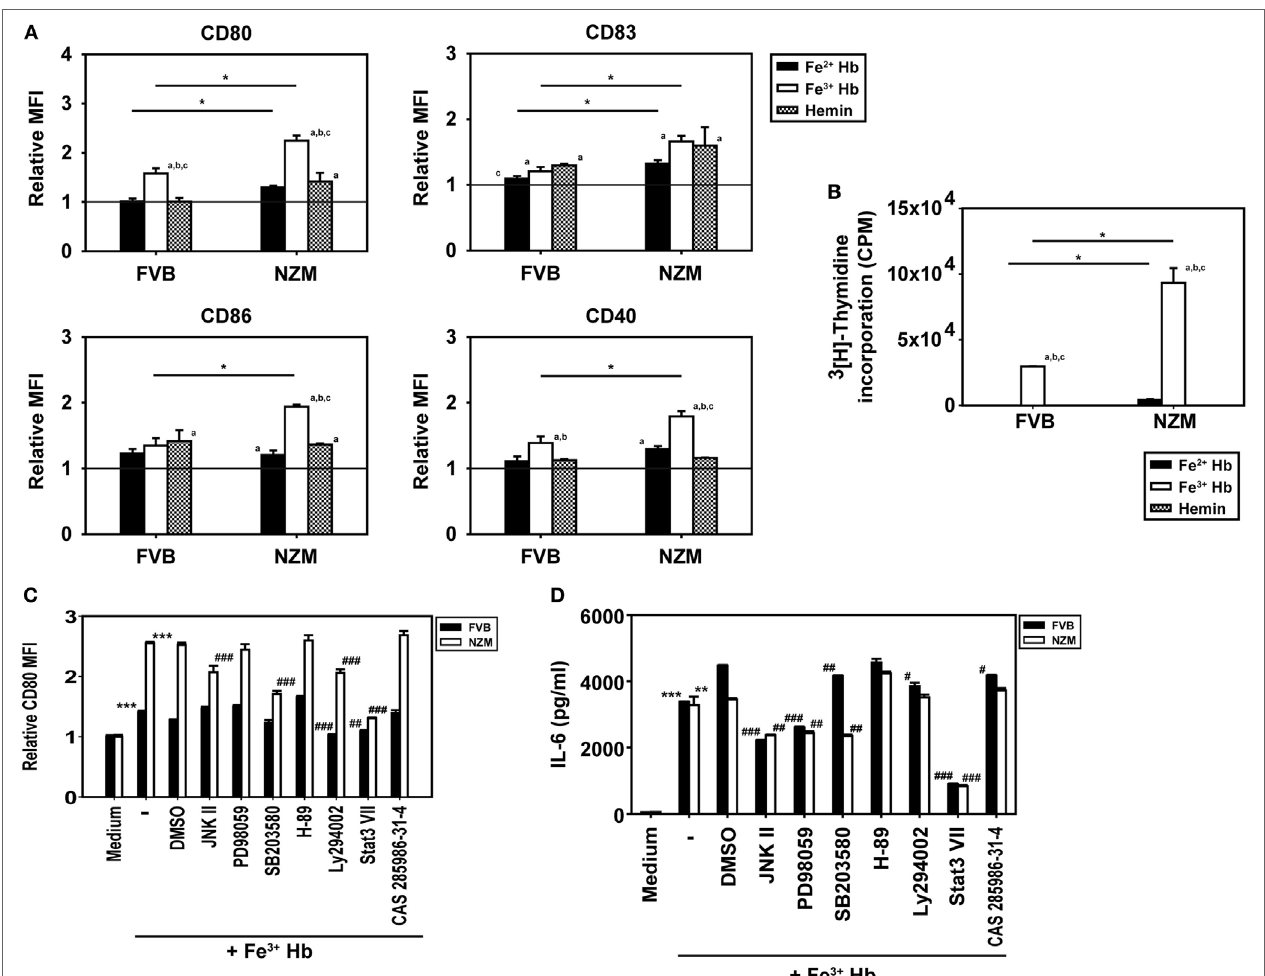
FigUre 3 | Effect of hemoglobin (Hb) on the maturation of bone marrow-derived dendritic cells (BMDCs) from 2-month-old FVB or NZM mice. (a) Expression of CD80, CD83, CD86, and CD40 on CD11c + BMDCs stimulated with 0.5 µM Hb (Fe 2 + or Fe 3 ) or 2 µM hemin. Relative MFI: ratio of mean fluorescence intensity of stimulated over un-stimulated (or vehicle-treated) BMDCs. (B) Proliferation of C57BL/6 splenocytes stimulated with γ -irradiated BMDCs (derived from FVB or NZM mice) subsequent to incubation with Hb (Fe 2 + or Fe 3 + ) or hemin. (c) Expression of CD80 on CD11c + BMDCs (derived from FVB or NZM mice) stimulated with Fe 3 + Hb in presence of signaling inhibitors (10 µM) or the vehicle dimethyl sulfoxide (DMSO). Relative MFI: ratio of mean fluorescence intensity of stimulated over un-stimulated BMDCs. (D) Estimation of IL-6 in culture supernatants of BMDCs derived from FVB or NZM mice stimulated with Fe 3 + Hb in the presence of various signaling inhibitors (10 µM) or DMSO. (c,D) JNK II: JNK inhibitor II; PD98059: MEK/ERK inhibitor; SB203580: p38 inhibitor; H-89: PKA inhibitor; Ly294002: PI3K inhibitor; Stat3 VII: Stat3 inhibitor VII; CAS 285986-31-4: Stat5 inhibitor. * p < 0.05, ** p < 0.005, *** p < 0.001 vs medium; # p < 0.05, ## p < 0.005, ### p < 0.001 vs DMSO. In all graphs, data represent mean ± SEM. Data derived from three independent experiments, each carried out in triplicate ( n = 18; 9 NZM, 9